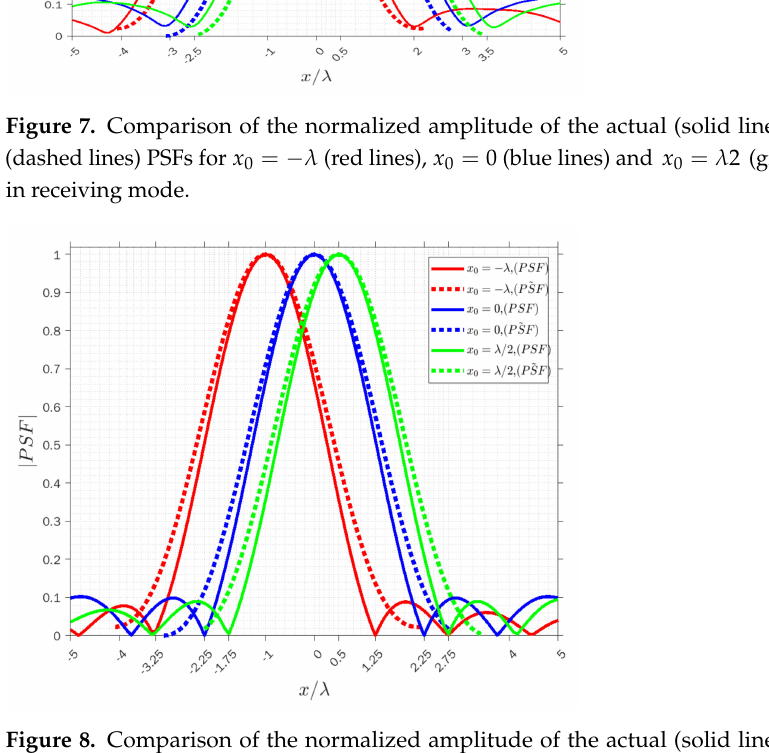
Figure 8. Comparison of the normalized amplitude of the actual (solid lines) and approximated (dashed lines) PSFs for x 0 = − λ (red lines), x 0 = 0 (blue lines) and x 0 = λ 2 (green lines) when y = 0 in transmission